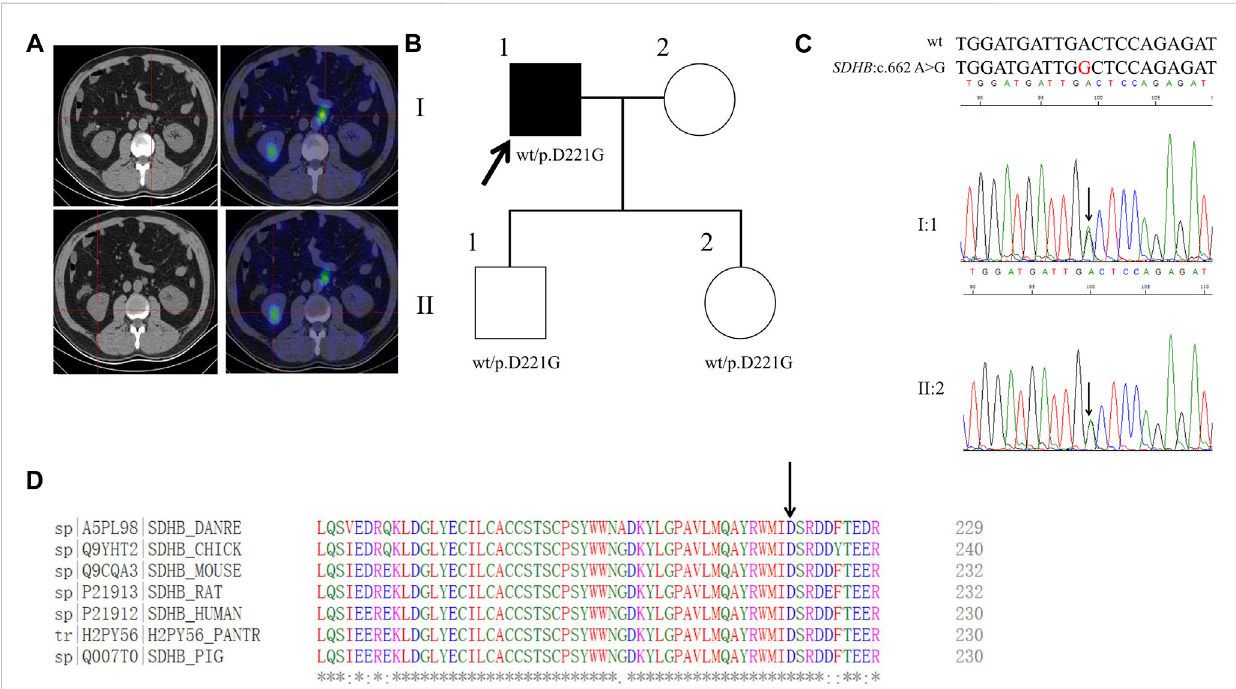
FIGURE 5 ClinicalandgeneticcharacteristicsofProband5. (A) 131I-MIBGSPECT/CTimagingina53-year-oldmalepatientwithPPGLhadshownarightkidney massandaleftretroperitonealoccupancy.CT(left)andSPECT/CT(right)transaxialsectionsareshownfortheleftretroperitonealoccupancy(upper)and the right kidney mass (bottom). (B) Pedigree of the Proband 5 family with PPGL. Squares and circles indicate males and females, respectively; Roman numerals indicate generations; and Arabic numerals indicate individual family members. Each member ’ s SDHB genotype are shown below the squaresandcircles.Wt,wildtype.D,asparticacid.G,glycine. (C) DNAsequencingdataoftheProband5(I:1)andhisdaughter(II:2)withtheheterozygous variant of SDHB :c.662 A > G. wt, wild type. (D) Multiple protein sequence alignment of seven species for SDHB p.D221 (arrow). An asterisk (*) indicates positionsthatare100%conservedinthealignment,andacolon(:)indicatesconservationbetweengroupsofstronglysimilarproperties,whilstaperiod(.) indicates conservation between groups of weakly similar properties. The residues in the alignment are coloured to indicate their physicochemical properties. Red indicates small and hydrophobic amino acids, blue indicates acidic residues, magenta indicates basic and green denotes hydroxyl/ sulfhydryl/amine